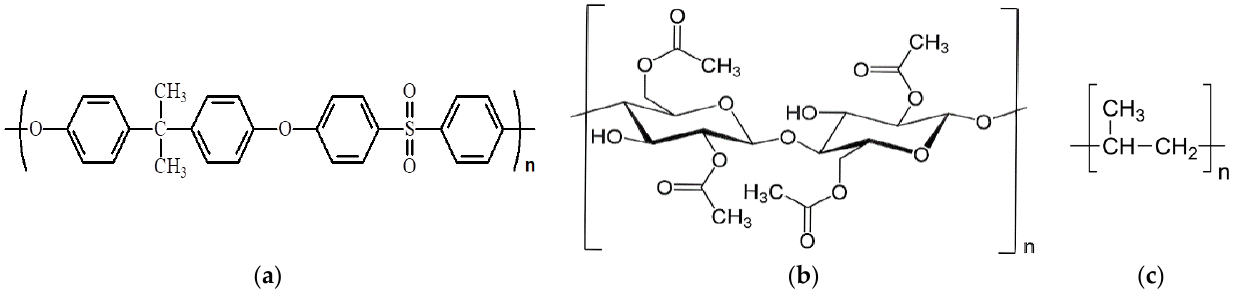
Figure 3. The chemical structure of ( a ) polysulfone (PSf), ( b ) cellulose acetate, and ( c ) polypropylene (PP). Cellulose acetate (CA) (Figure 3b) powder, respectively, Mn = 50,000 g/mol, (cid:36) = 1.3 g/cm 3 (Sigma-Aldrich, Merck KGaA, Darmstadt,